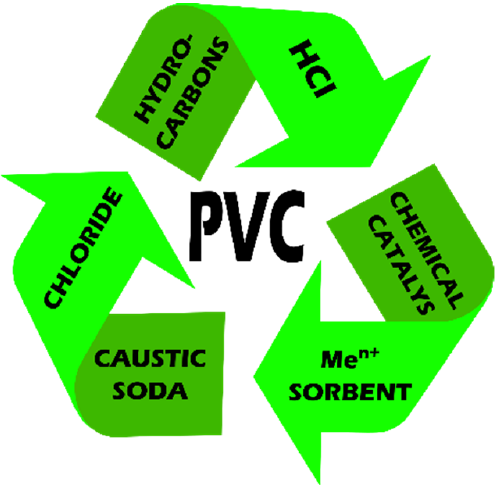
Figure 6. Main directions of substance recovery as a result of feedstock recycling of PVC.